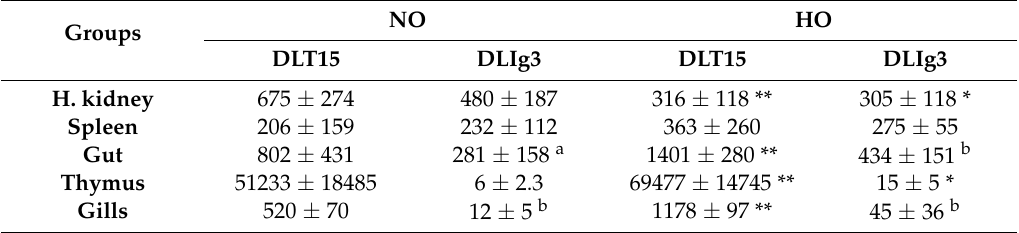
Table 1. Immuno-histochemistry results. Cellular density ( N cells/mm 2 ) of DLT15+ and DLIg3+ lymphocytes (T- and B-cells, respectively) in lymphoid tissues of sea bass reared under sub-optimal water oxygen (6 mg/L, NO group) or hyper-oxygenation (13 mg/L, HO group). NO HO Groups DLT15 DLIg3 DLT15